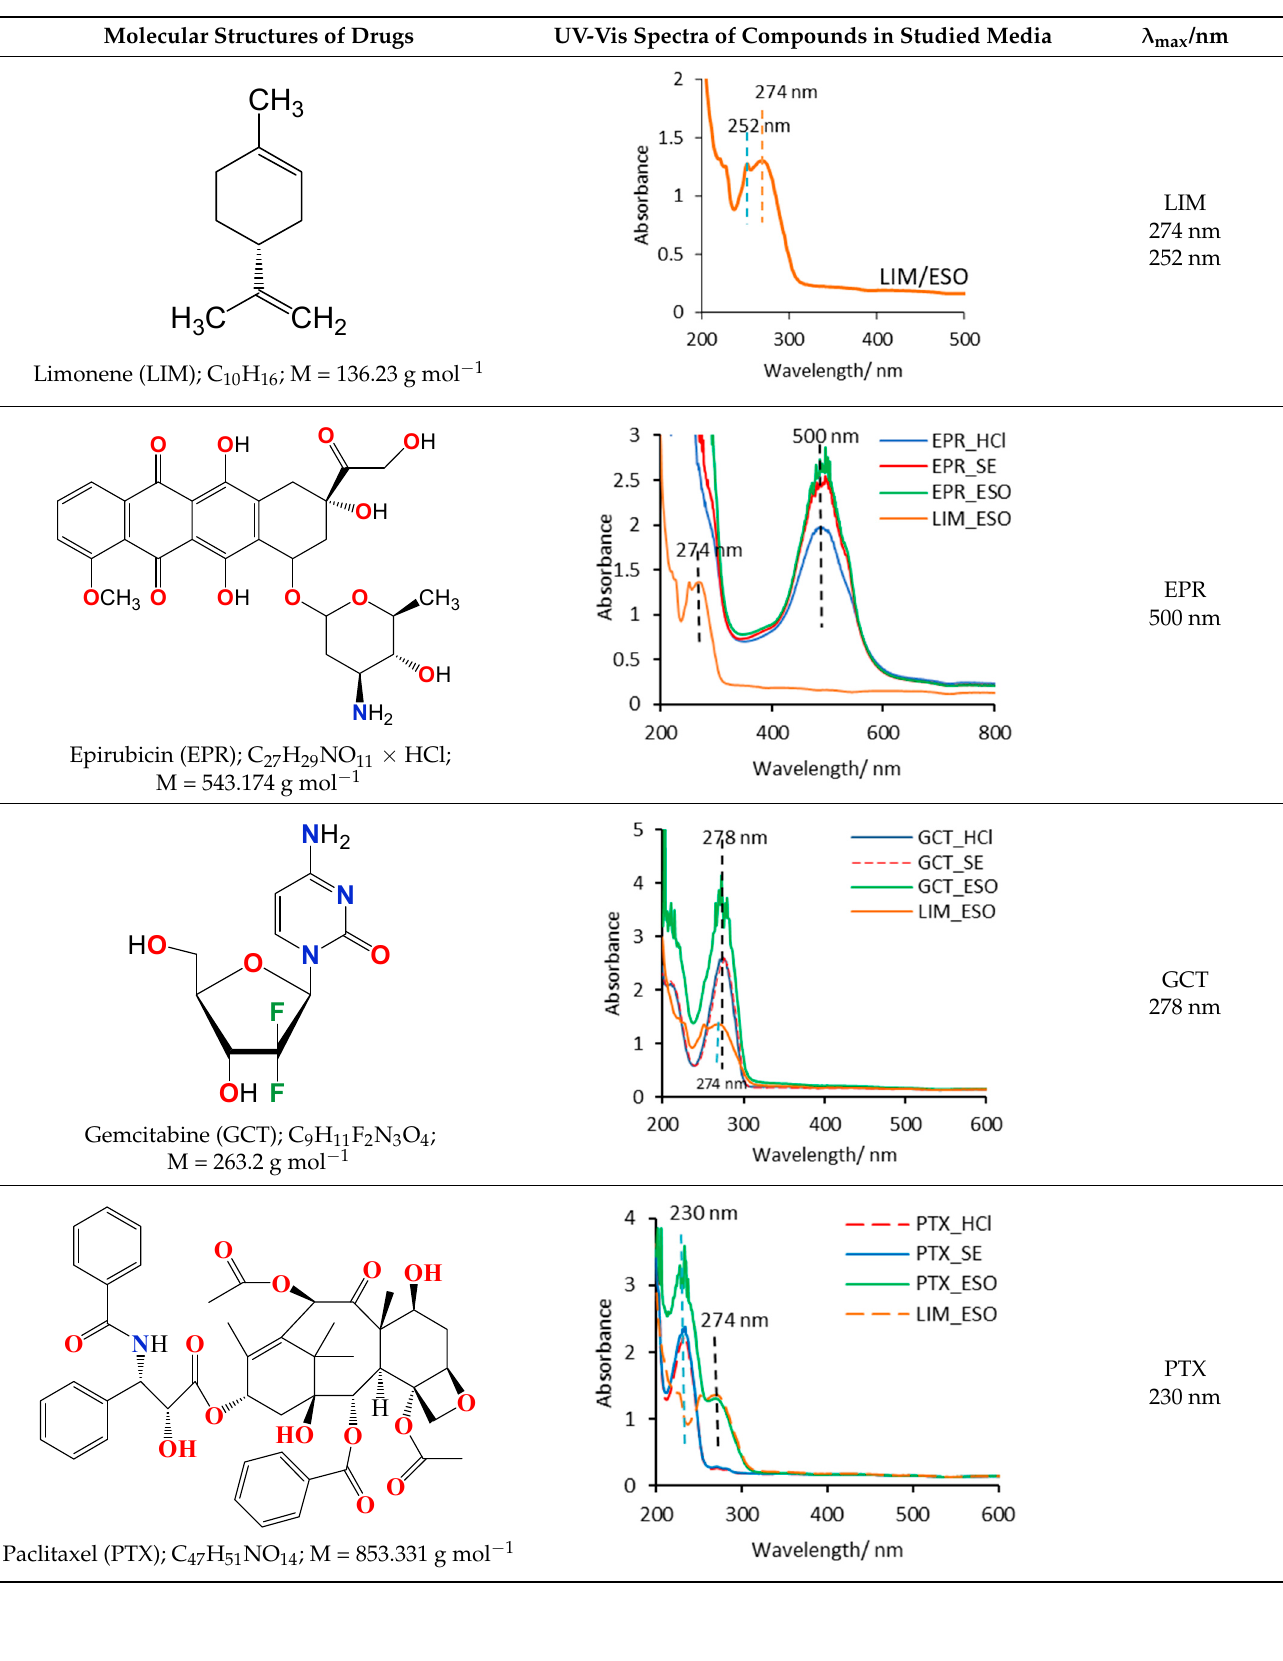
Table 1. Molecular formulas and UV-Vis spectra of chemotherapeutics recorded in the supporting electrolyte without and with orange essential oil.